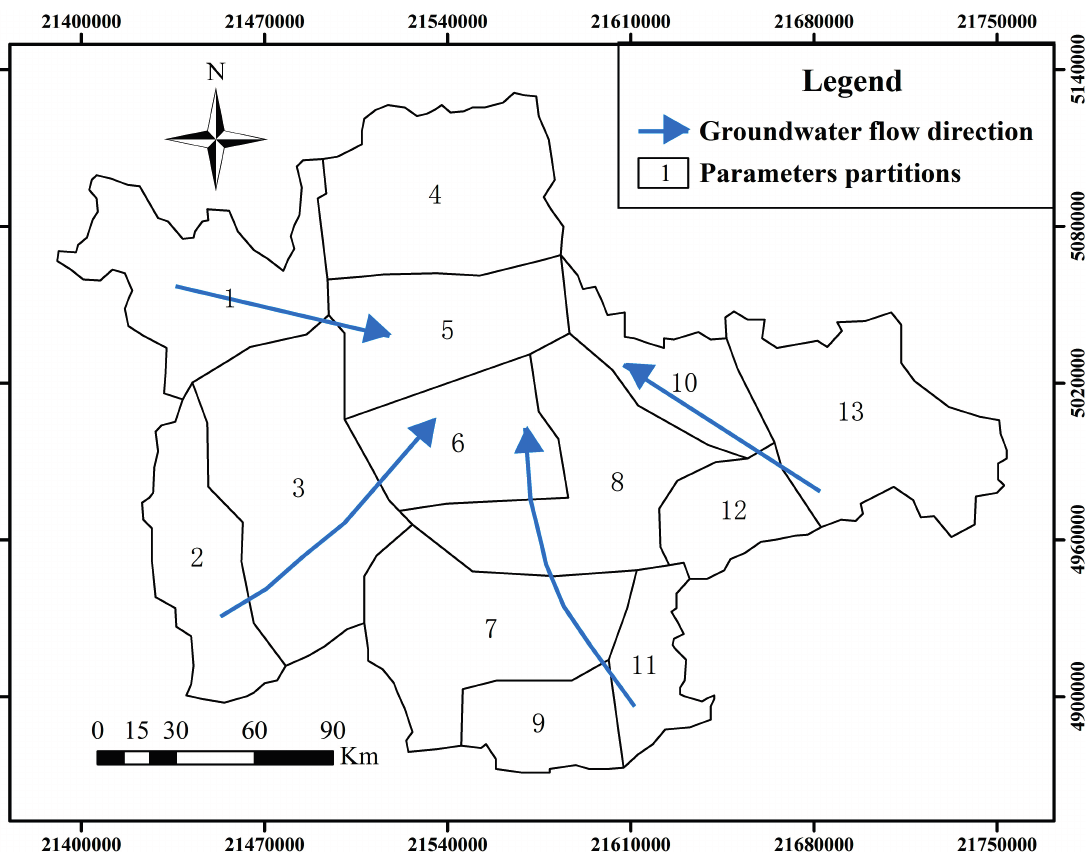
Figure 2. Groundwater flow direction and parameters partitions of study